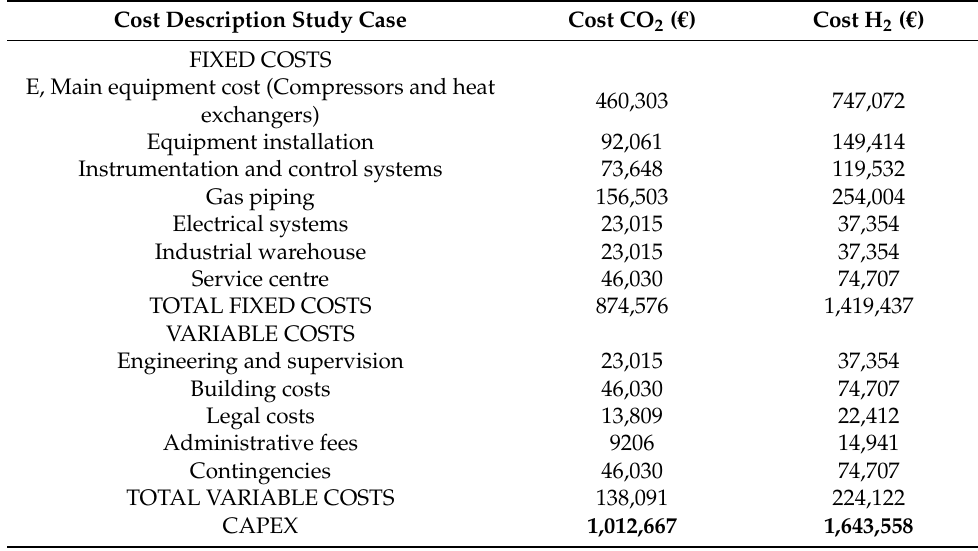
Table 4. Detailed description of CAPEX considering a storage pressure of 20 bar. Base case.